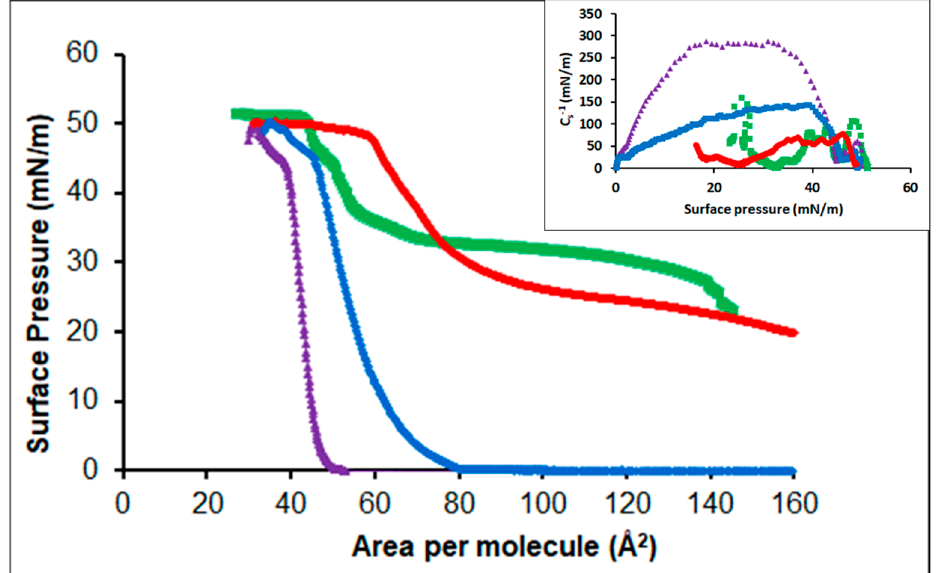
Figure 9. Surface pressure-area isotherms and elastic modulus curves (inset) for CHO-POPC mixtures: X CHO = 0.567, in the absence (violet) and in the presence (green) of lysozyme; X CHO = 0.179, in the absence (blue) and in the presence (red) of lysozyme.